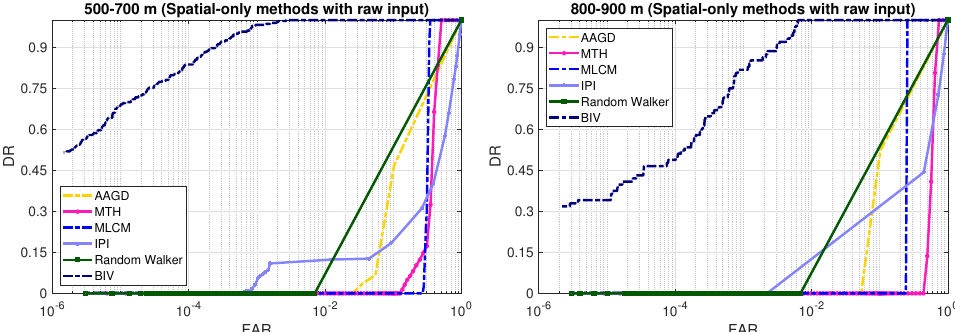
Figure 10. ROC curves comparison: spatial-only approaches (logarithmic x-axis). The spatial-only methods failed at both ranges when the input was